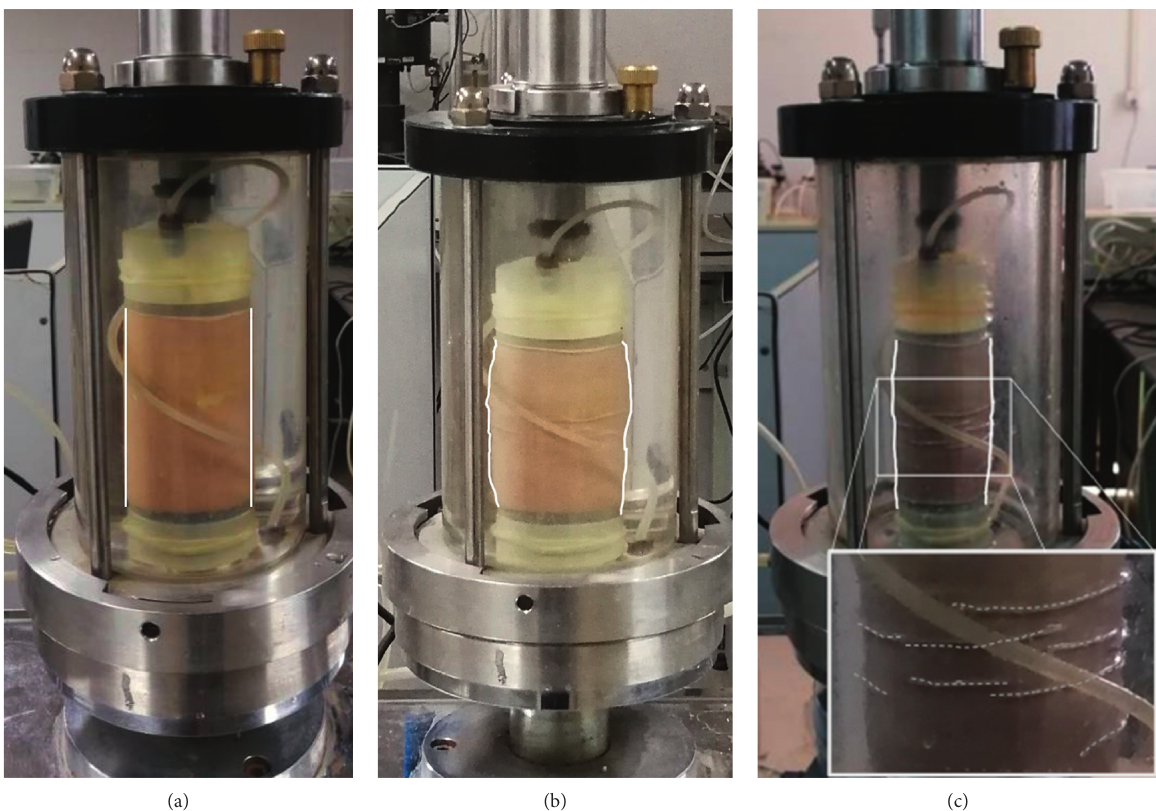
Figure 15: Typical schematic diagrams for samples: (a) Before consolidation. (b) Before unloading. (c) Completion of unloading.